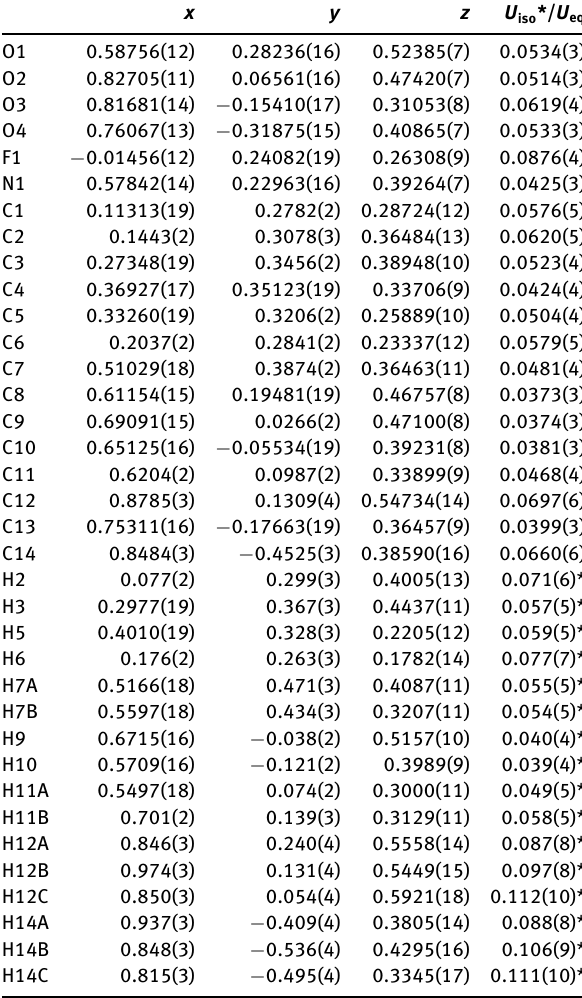
Table 2: Fractional atomic coordinates and isotropic or equivalent isotropic displacement parameters (Å 2